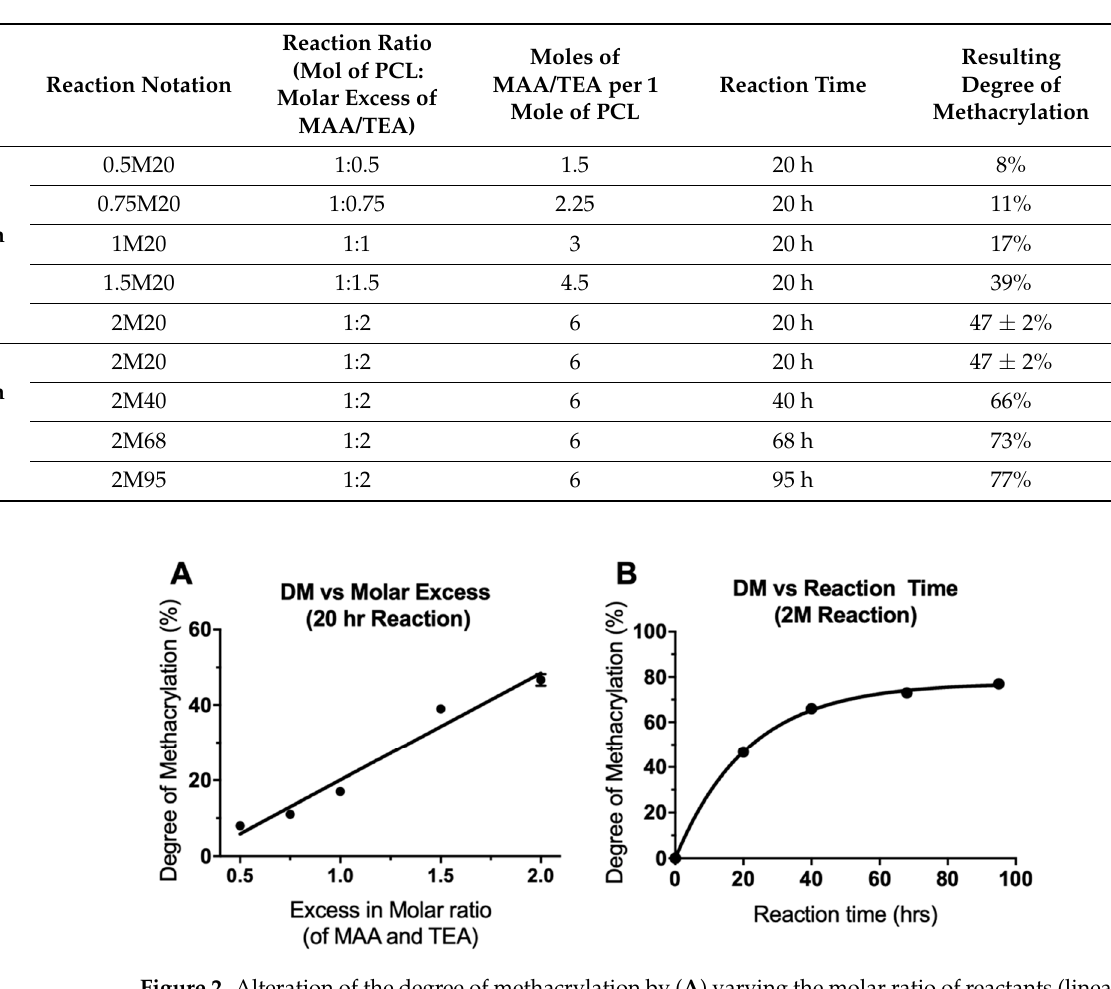
Figure 2. Alteration of the degree of methacrylation by ( A ) varying the molar ratio of reactants (linear regression curve fitted, R 2 = 0.96) and ( B ) varying the reaction time (one phase decay curve fitted, R 2 = 0.99). N = 1, n = 1, except for 2M20 where N = 3, n = 1 so mean ± SD shown only for 2M20 (error bars are too small to be observed in B ).